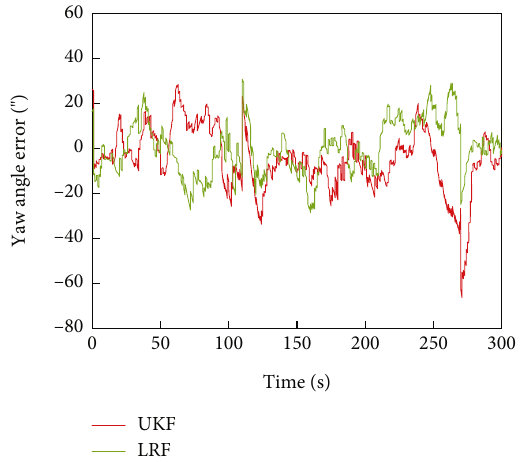
Figure 20: Z -axis position error contrast curves